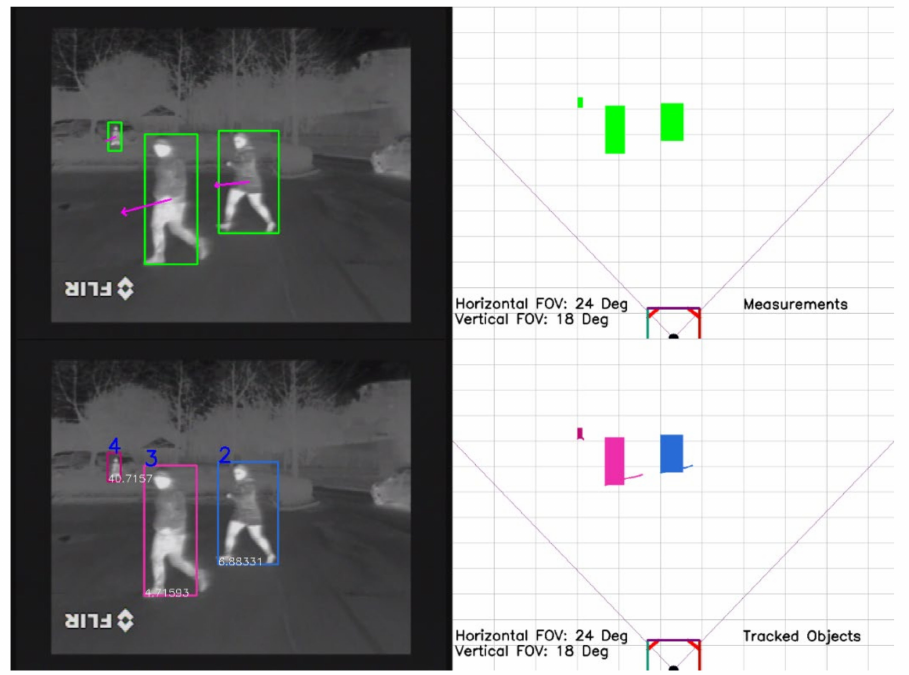
Figure 5. Pedestrians in a parking lot. The proposed tracking solution is able to track pedestrians of different sizes, even when they are partly